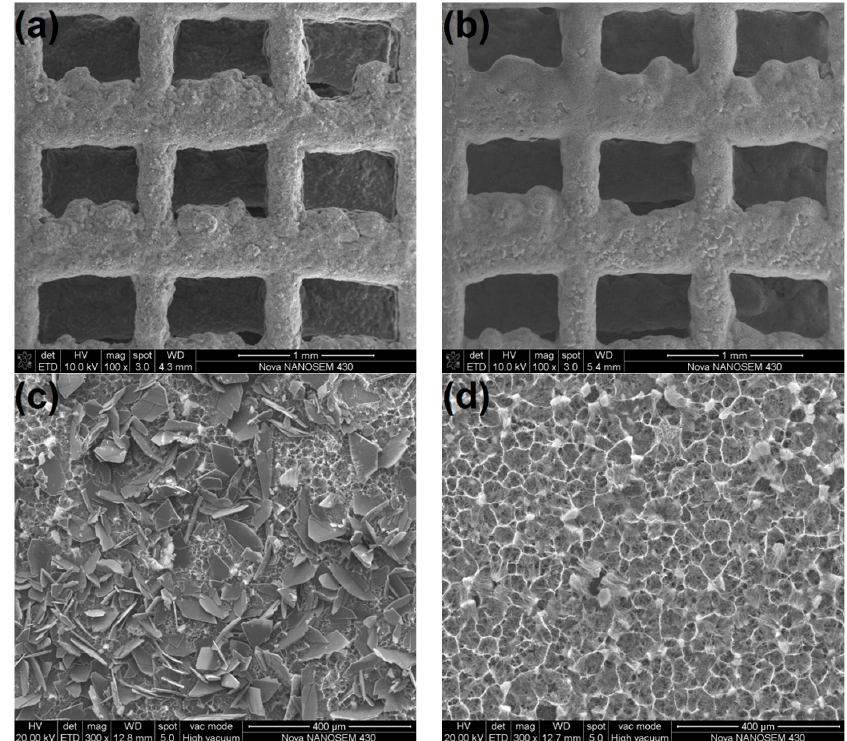
Figure 3. Scanning electron micrographs of coated SLM-Ti scaffolds: ( a , c ) the top surface and ( b , d ) the bottom surface.